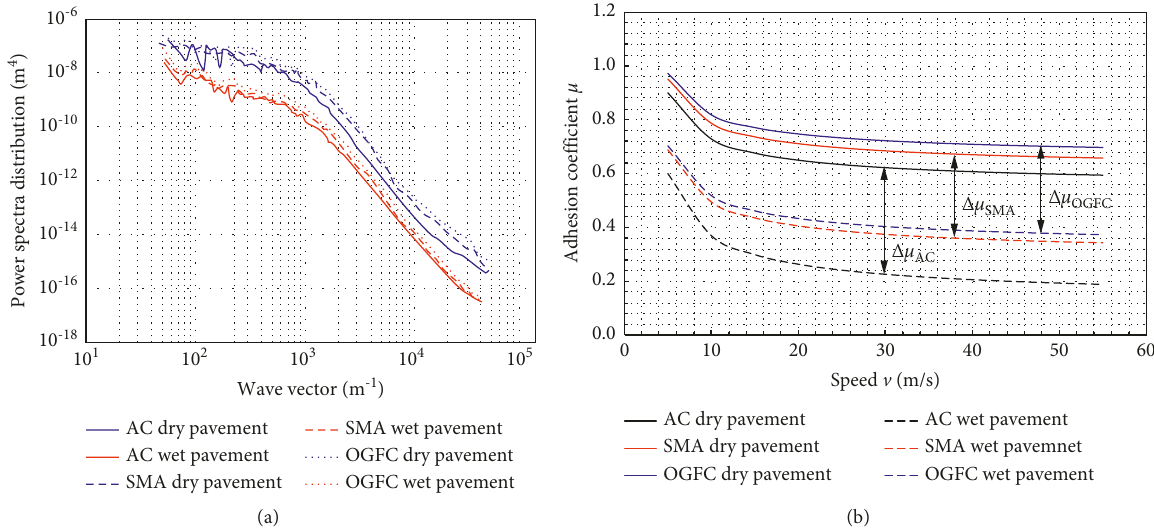
Figure 4: Adhesion characteristic on different road conditions: (a) 2D PSD of pavement texture; (b) adhesion coefficient curves varying with vehicle